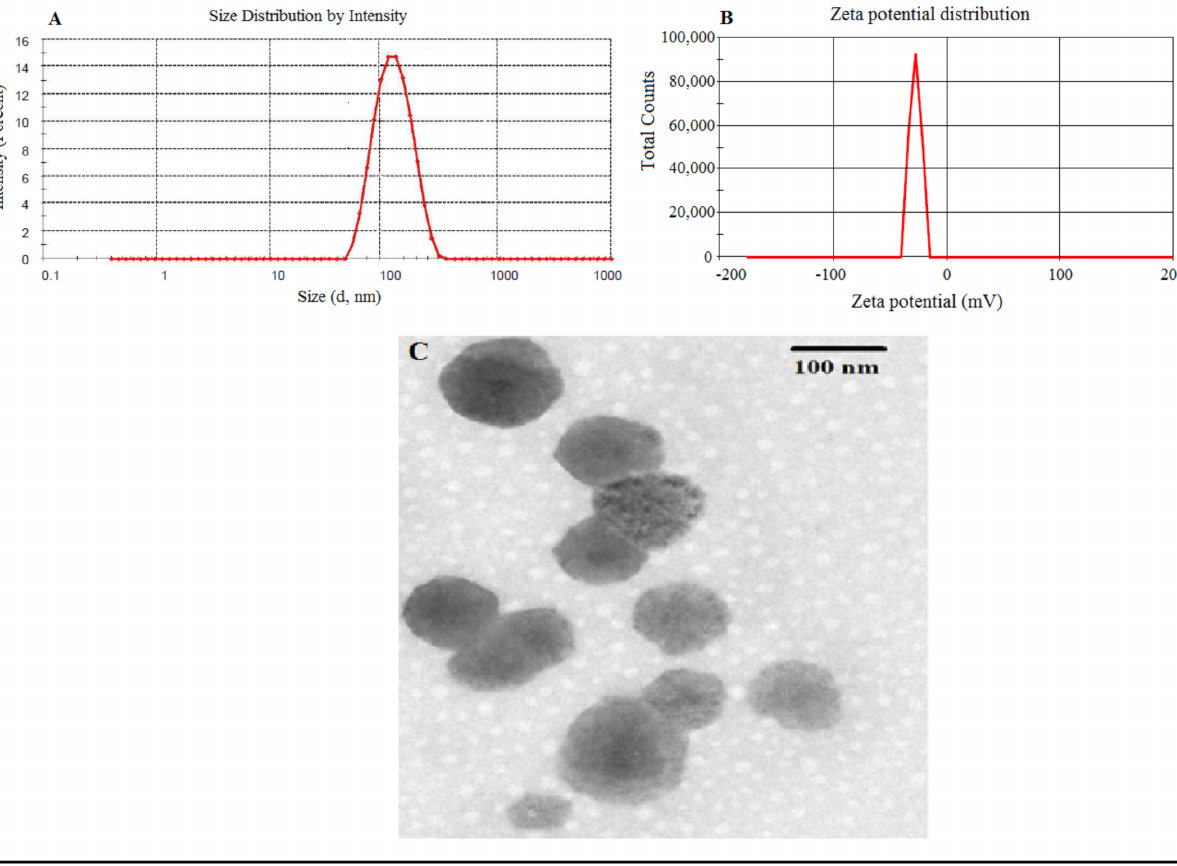
Figure 3. Optimized PLM-loaded glycerosomes ( A ) average vesicle size ( B ) zeta potential and ( C ) transmission electron